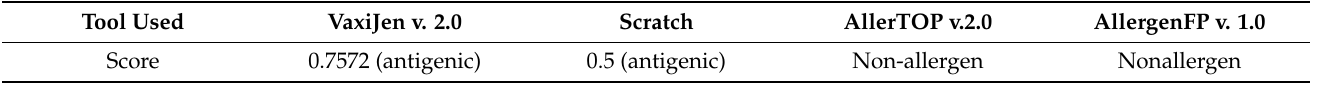
Table 5. Antigenicity and allergenicity analyses of the vaccine construct.